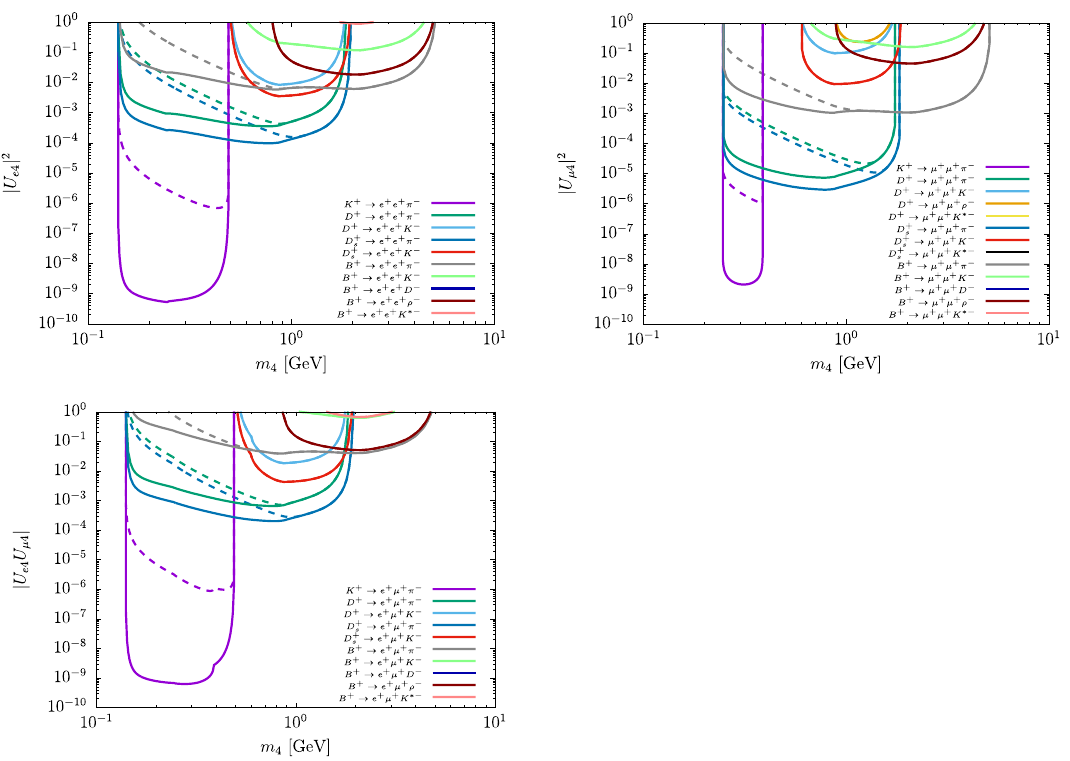
Figure 6 . Updated constraints on the relevant combination of leptonic mixing matrix elements ( j U ‘ U ‘ j ) arising from LNV pseudoscalar meson decays, as a function of the heavy sterile neutrino (cid:11) 4 (cid:12) 4 mass (GeV). Leading to the above plots, all active-sterile mixing angles were taken to be equal (i.e.,